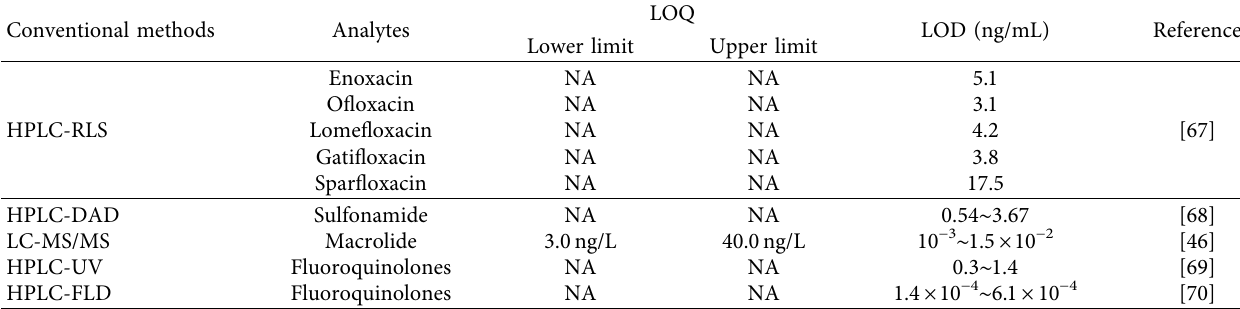
HPLC-RLS: high-performance liquid chromatography-tandem resonance light scattering; DAD: diode array detector; UV: ultraviolet detection; FLD: fluorescence detector; LC-MS/MS: liquid chromatography with tandem mass spectrometry; LOQ: limit of quantification (upper and lower limits of the method are extremes of the linear range of the method); NA: not